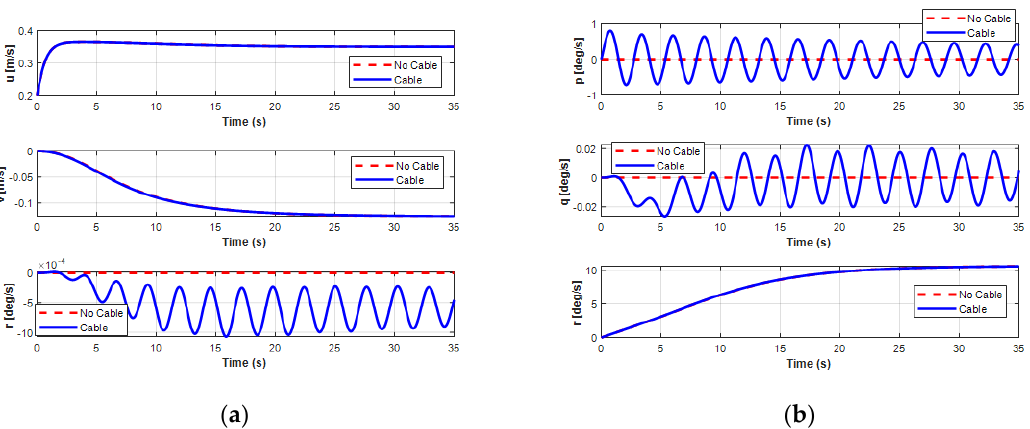
Figure 18. Simulation results of the position and orientation behaviors of the UUV turning: ( a ) position of the UUV; ( b ) orientation of the UUV.